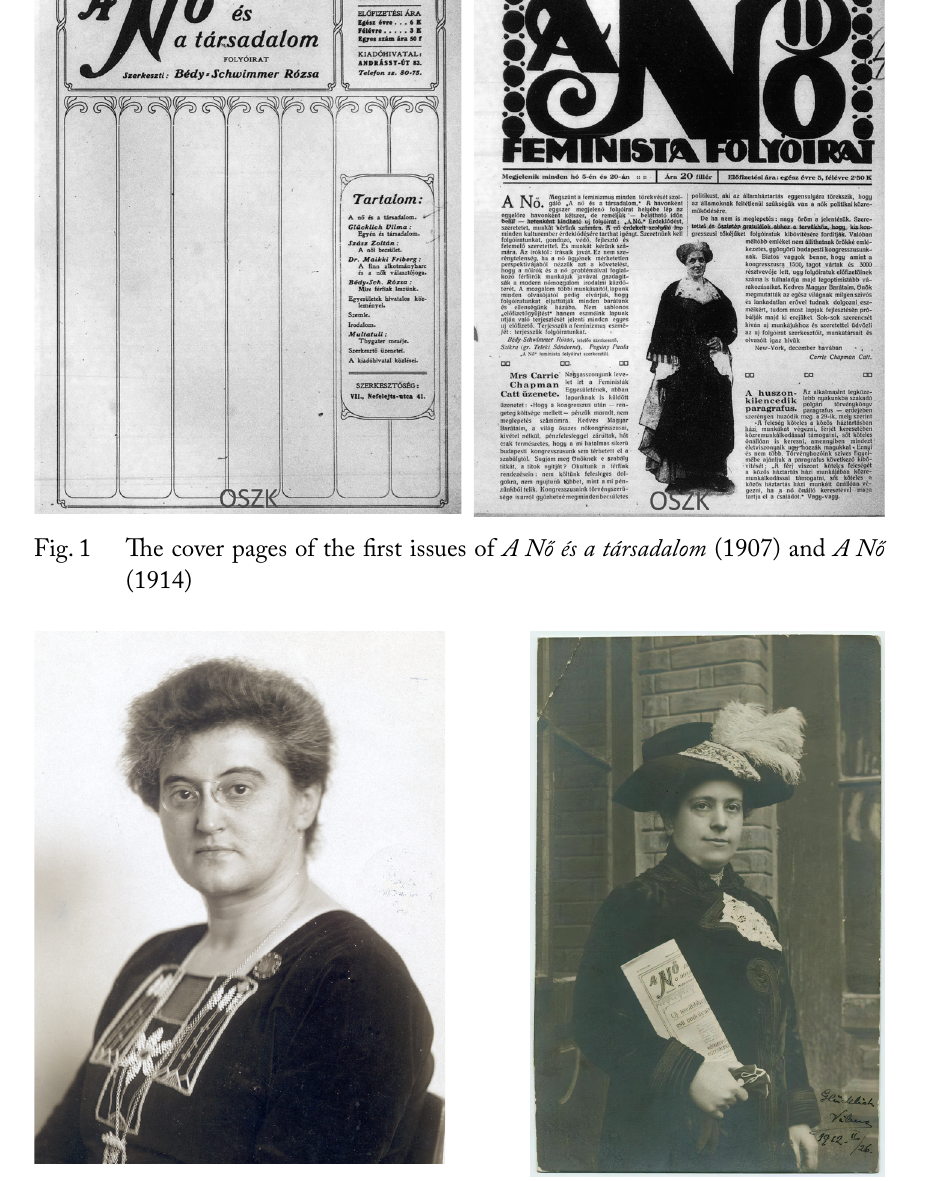
Fig. 2 The founders of the Hungarian Feminist Association, Rózsa Schwimmer (1877–1948) and Vilma Glücklich (1872–1927). Glücklich is holding a copy of A Nő és a